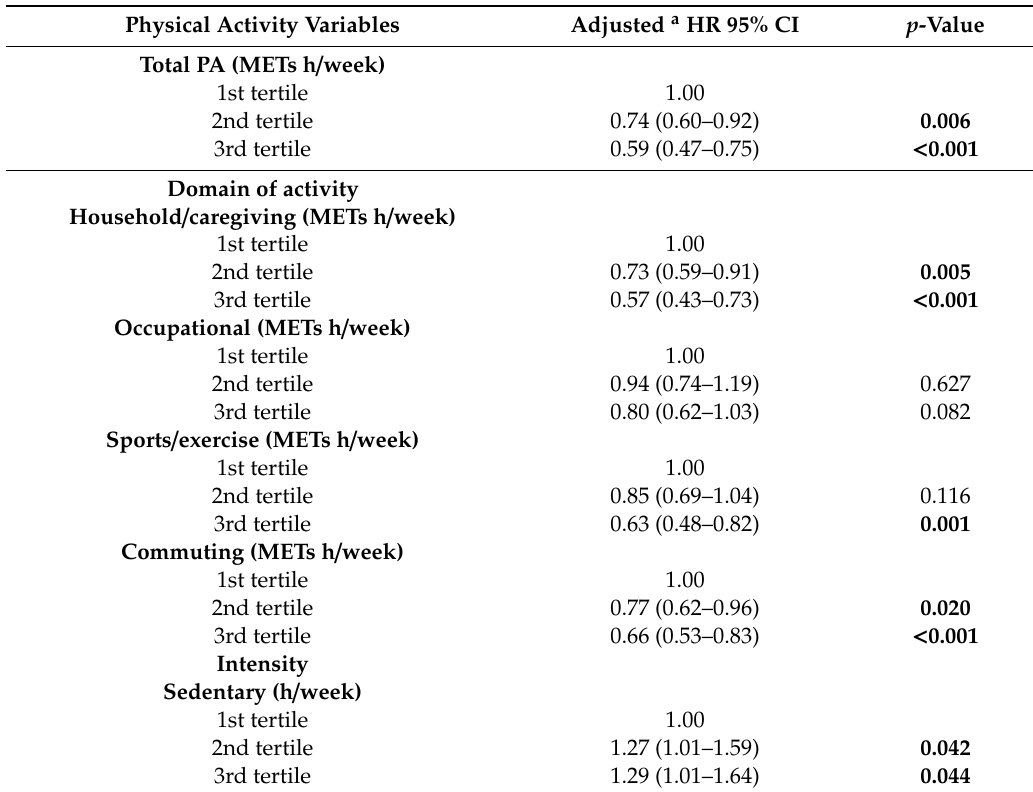
Figure 2. Kaplan-Meier curves of ‘any breastfeeding’ in the first twelve months postpartum for mothers who met and not meet the recommendation of physical activity during pregnancy (log-rank test p = 0.0005). The cuto ff point for physical activity used the DHHS Guidelines [4]. The adjusted hazard ratios showing a significant association between prenatal physical activity on ceasing breastfeeding are presented in Table 3, also except for the vigorous and occupational activities. Table 3. Cox regression models of any breastfeeding duration and physical activities among Vietnamese women ( N =